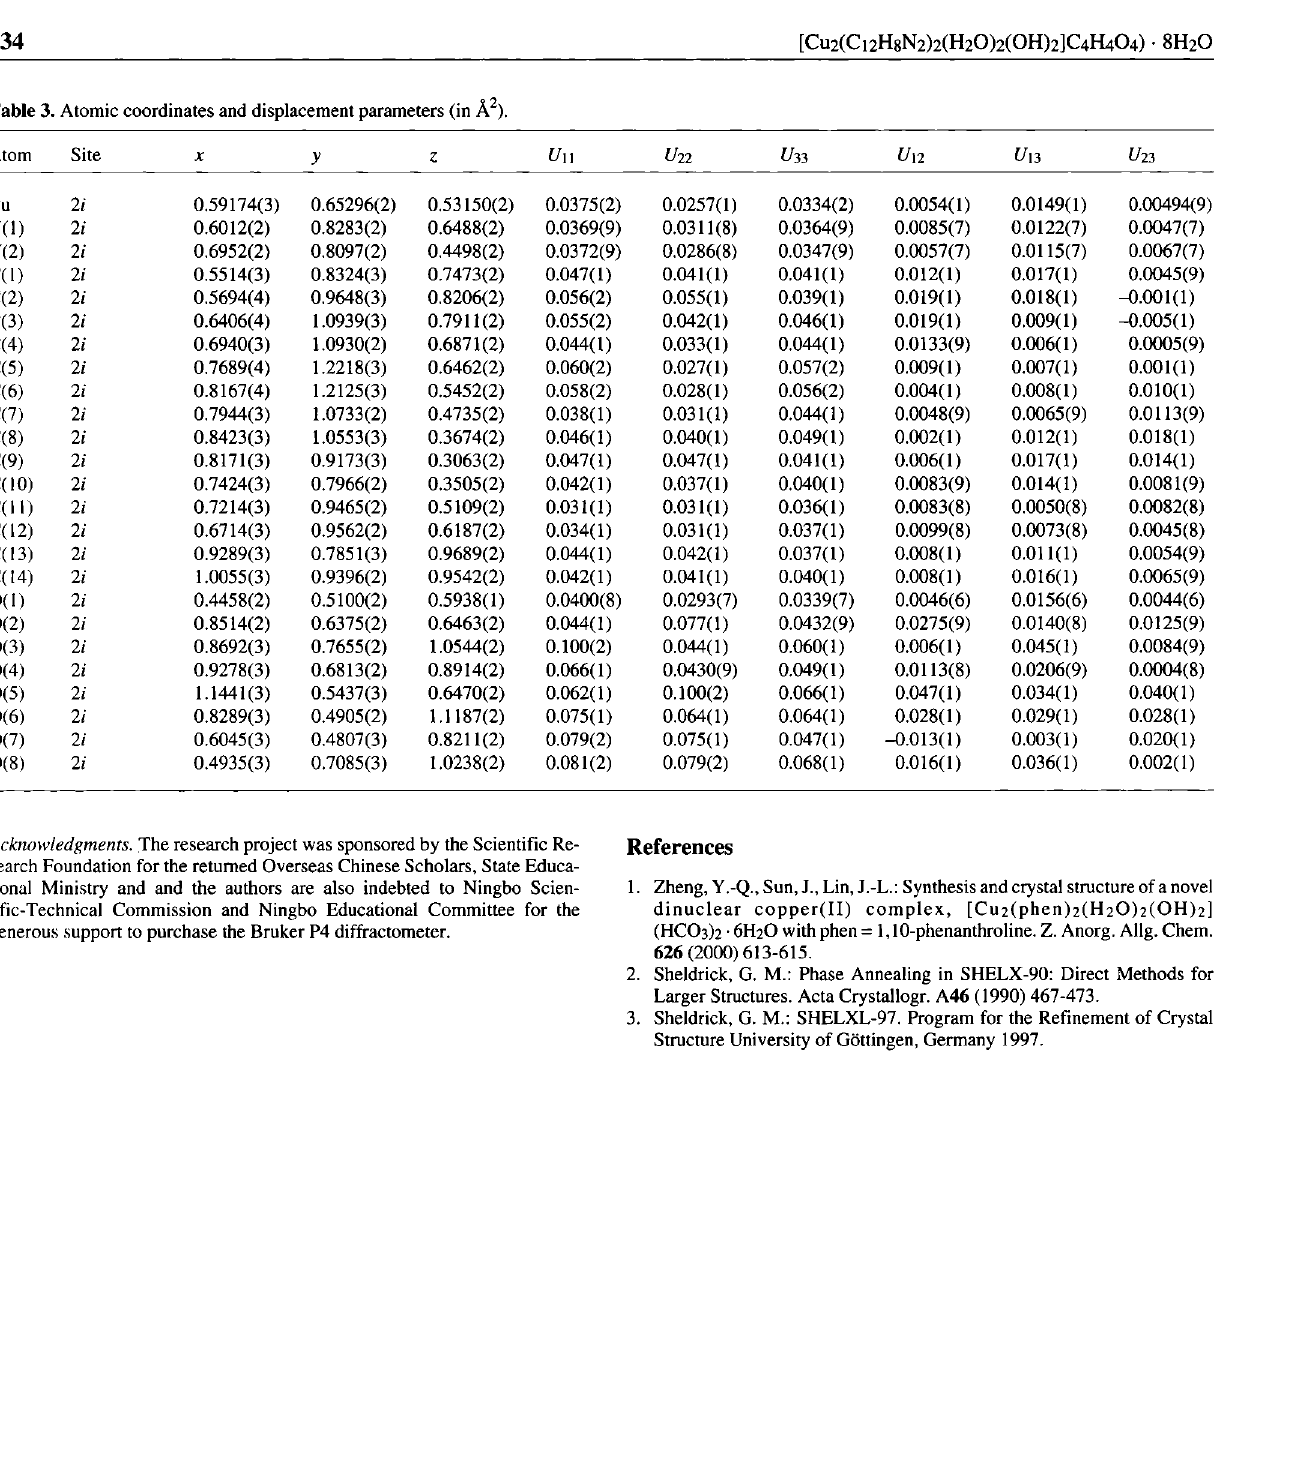
Table 3. Atomic coordinates and displacement parameters (in Â 2